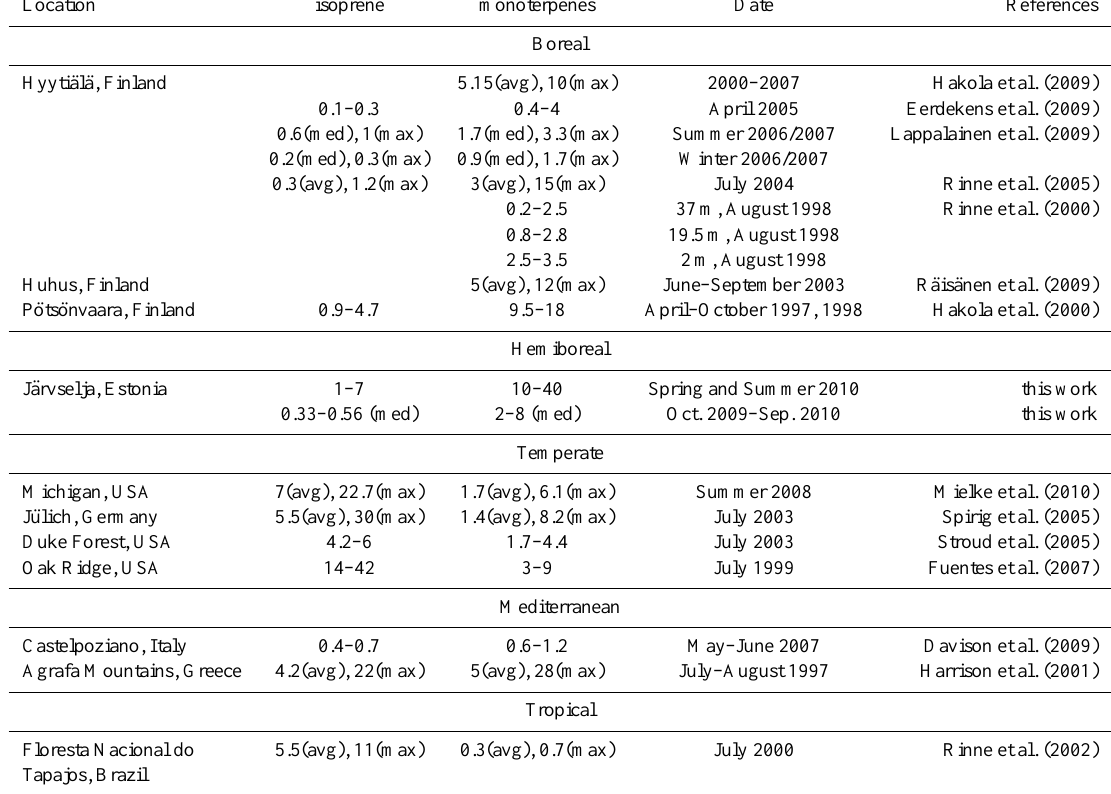
Fig. 7. Relation between atmospheric ozone mixing ratio and the difference between the samples. As the measurements were conducted on two heights, the ozone mixing ratios are clustered. The lower mixing ratios were measured inside and the higher mixing ratios above the canopy. The correlations r between the differences and the ozone mixing ratios are small and the green linear trend lines are included to visually accentuate the correlations. The unit for the difference is given in µg m − 3 and for the ozone mixing ratio in ppbv. Table 6. Selection of ambient BVOC concentrations (µgm − 3 ) reported in the literature for several forest ecosystems. If needed, volume mixing ratios have been converted by taking the temperature and air pressure of the measurement period reported into account (cf. Seinfeld and Pandis (2006)). avg=mean value, med=median value, max=maximal value of the measurements reported.